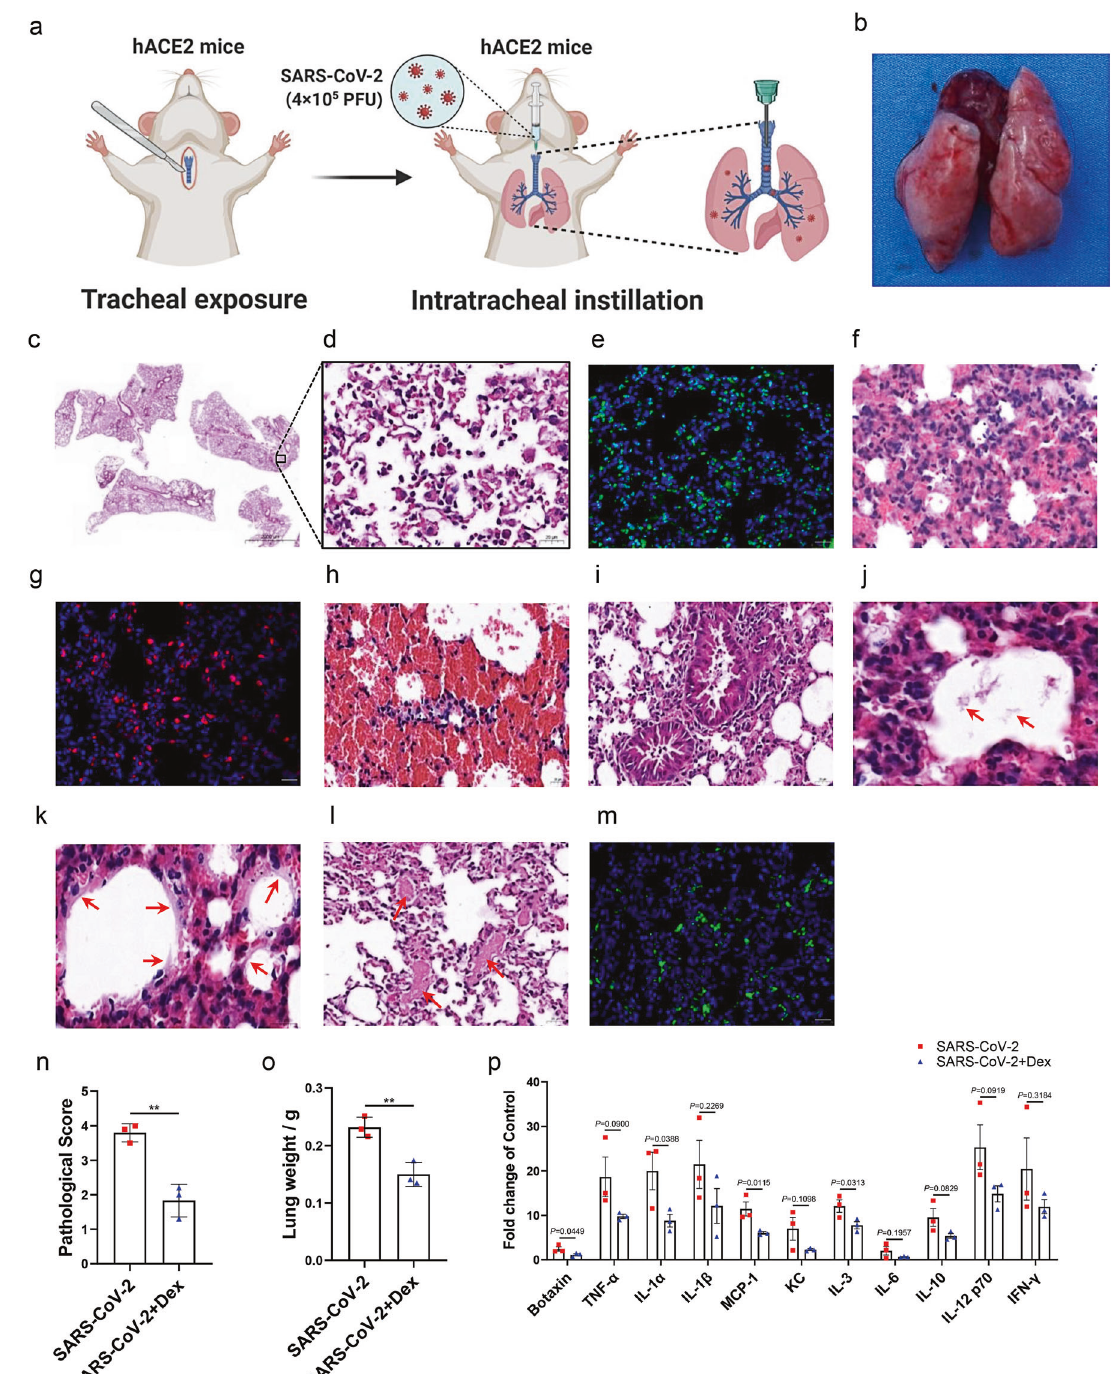
proteinaceous debris in the alveolar space, or apparent edema in lung tissues, were still scored as 3. More than 60% of lung consolidated with neutrophil and monocyte/macrophage in fi ltration, was scored as 4. Even if there was less severe in fl ammatory cell in fi ltration in lung tissues, either one of the following pathological changes, such as the diffuse disruption of alveolar walls without the recognizable architecture, or the apparent lung epithelial or endothelial cell death, or apparent hemorrhage or thrombi in vessels, or the hyaline